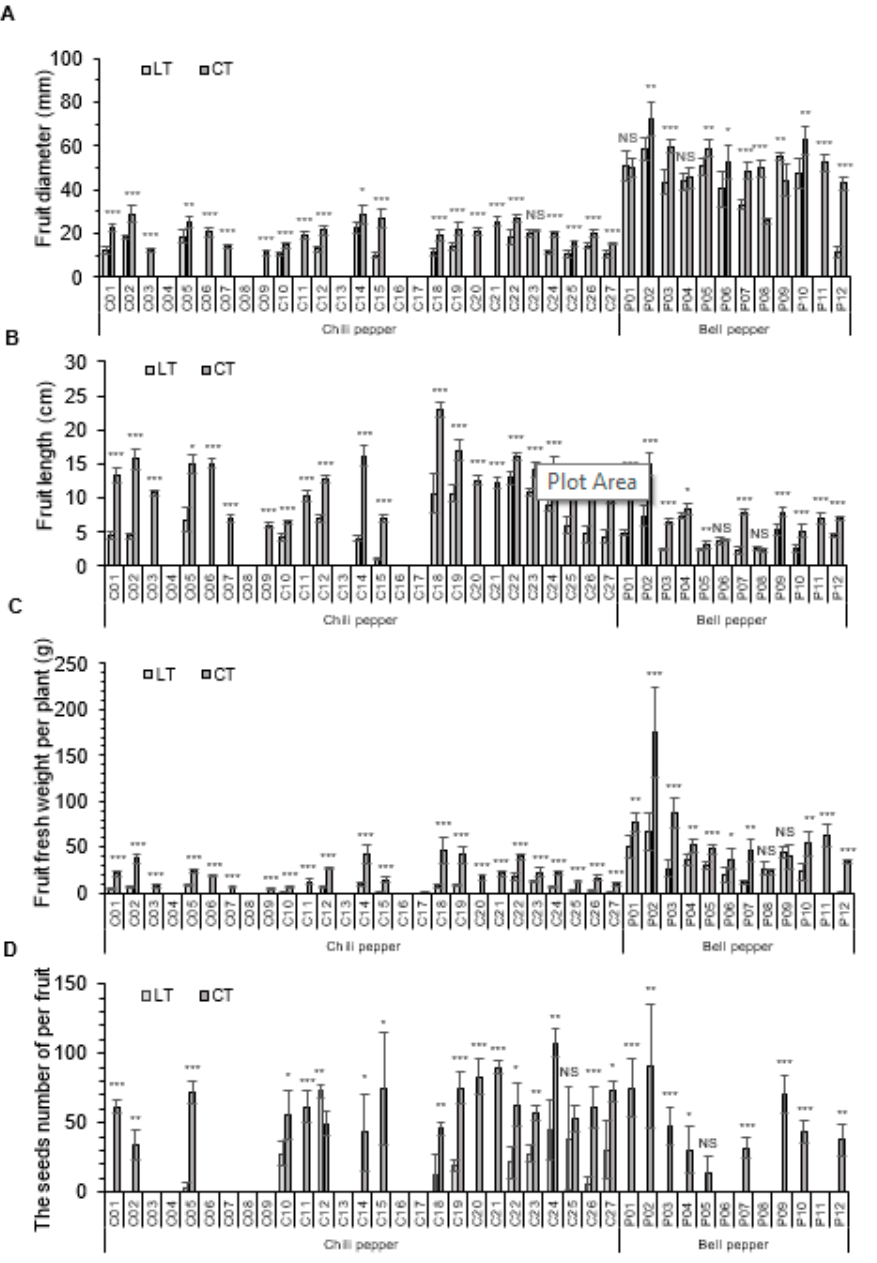
Figure 3. The evaluation of reproductive traits on ( A ) fruit diameter, ( B ) fruit length (cm), ( C ) fruit fresh weight, and ( D ) the number of seeds among 39 pepper accessions in LT and CT greenhouses. The reproductive parameters were measured at 120 days after transplanting. Significant differences were evaluated with Student’s t -test with p ≤ 0.05, p ≤ 0.01, and p ≤ 0.001 and denoted by *, **, and ***, respectively. NS means not significant and bars indicate ± standard deviation ( n = 3).